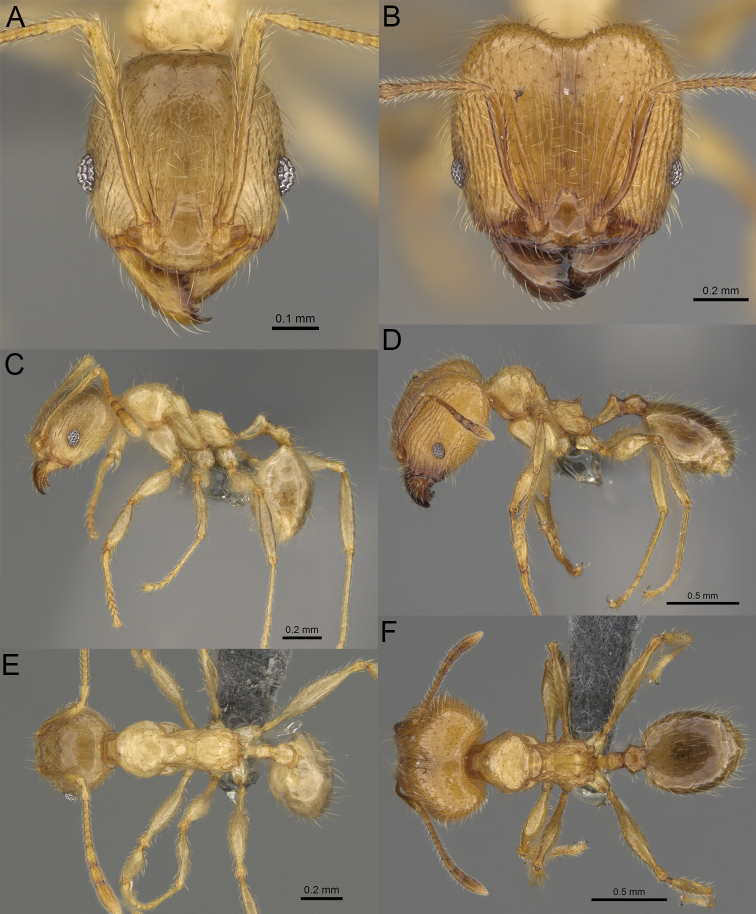
Pheidole
masoandro sp. nov., full-face view (A), profile (C), and dorsal view (E) of paratype minor worker (CASENT0923293) and full-face view (B), profile (D), and dorsal view (F) of holotype major worker (CASENT0704282).